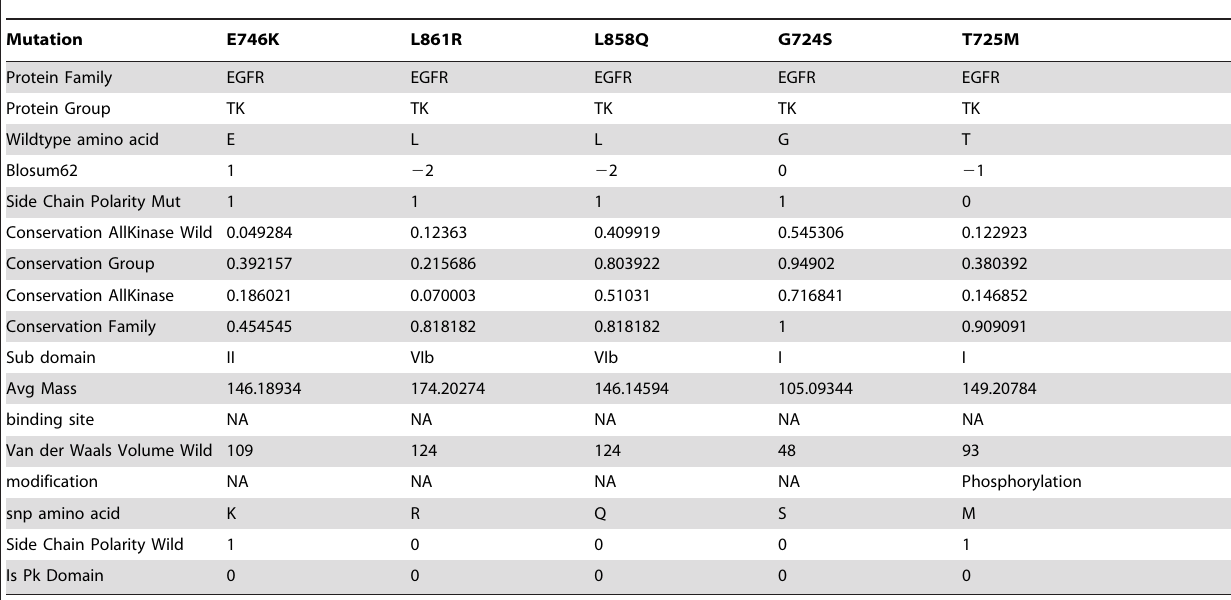
Table 5. Feature values of selected